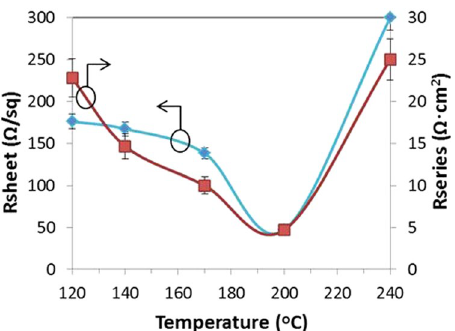
Figure 4. Sheet resistance of the annealed composite AZO/Ag NWs layer and series resistance values of the corresponding 3-D NWSCs with the AZO/Ag NW composite top electrode annealed at different temperatures. Note the solid lines are only guides to the eye to help separate the experimentally measured R sheet and R series